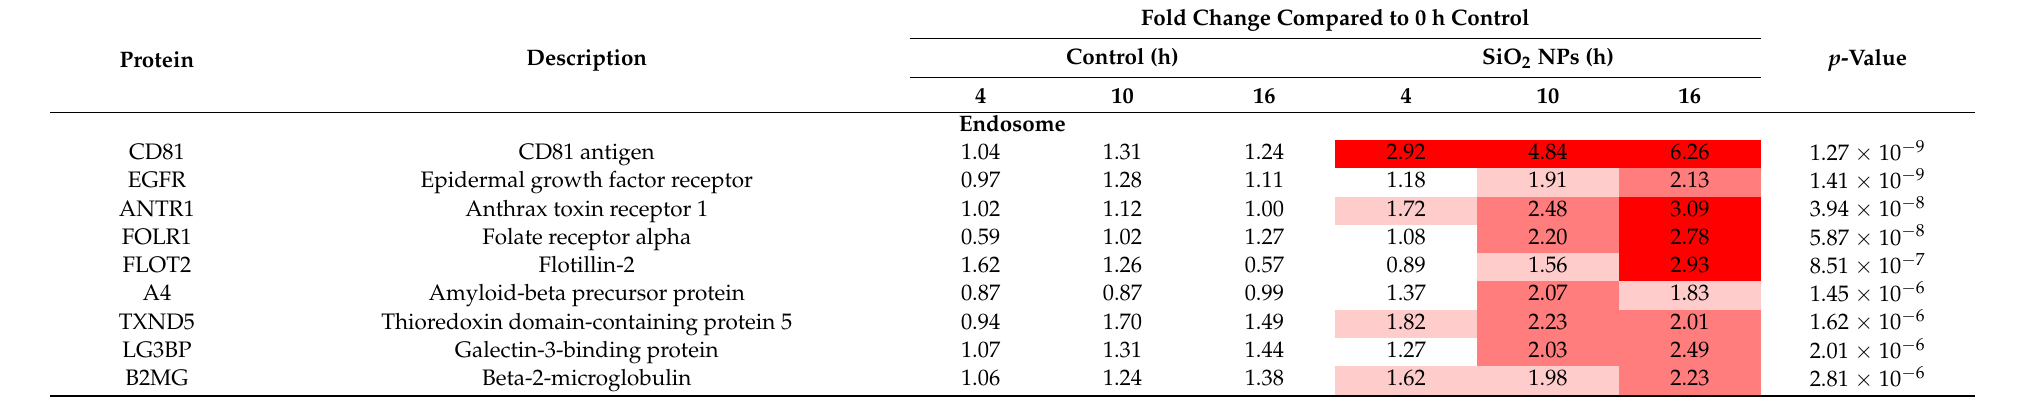
Table 3. List of upregulated proteins from control and SiO 2 NP groups of HepG2 cells by the exposure time associated with the biological pathway.